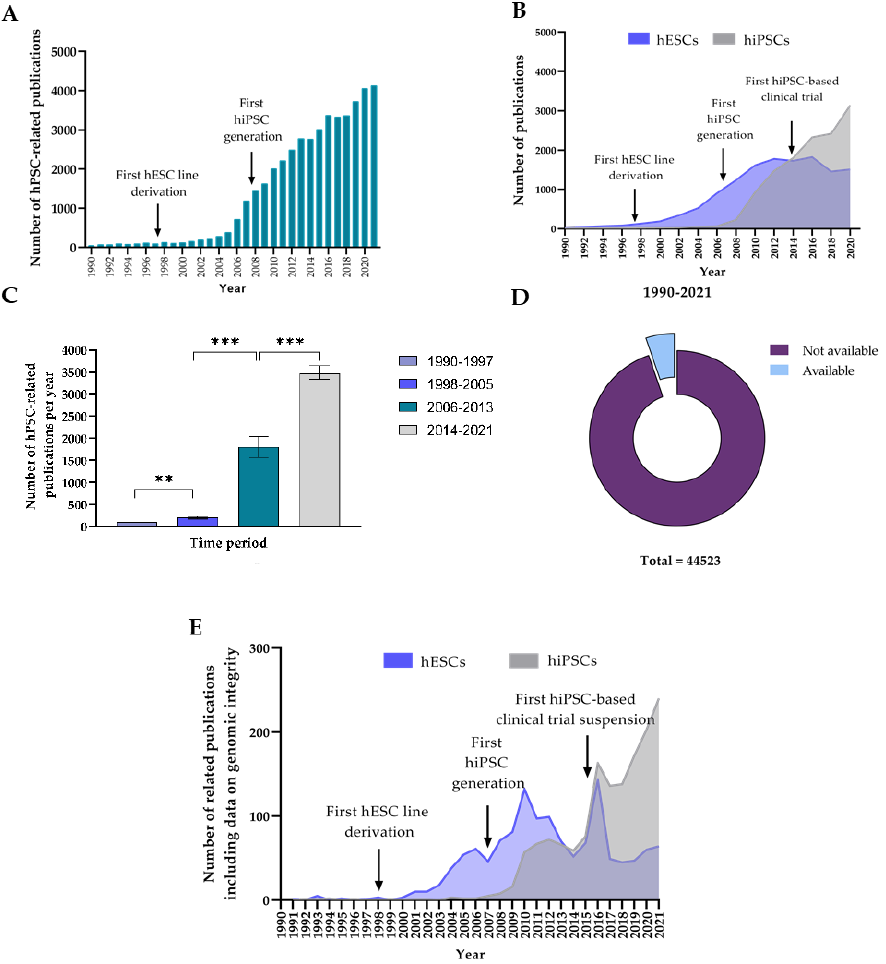
Figure 1. Analysis of the evolution in number of human pluripotent stem cell (hPSC)-related publications and level of reporting of hPSC genomic integrity monitoring: ( A ) Bar graph representing the number of publications on hPSCs per year; ( B ) compound line graph of trend of publications per year during on human embryonic stem cells (hESCs) and human induced pluripotent stem cells (hiPSCs). Notice the three inflection points relative to three major events in the PSC field: the first hESC line derivation by Thomson in 1998 [2], the first hiPSC generation by Takahashi and Yamanaka in 2007 [4] and the RIKEN first hiPSC-based clinical trial in 2013; ( C ) histogram of average number of publications per year in distinct temporal windows; ( D ) publications of hPSC research containing information on genomic integrity monitoring of hPSCs. Available segment indicates the percentage of articles with published data about genomic integrity of hPSCs, where the mean ± the standard error of the mean (SEM) is showed; ( E ) trend of publications per year on hESCs and hiPSCs reporting information on genomic integrity of cells used for the study: increasing interest about monitoring genomic integrity follows critical events about their usage.